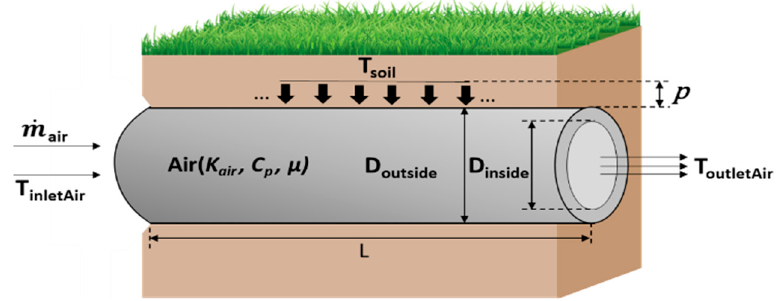
Figure 6. Heat balance of a buried pipe.